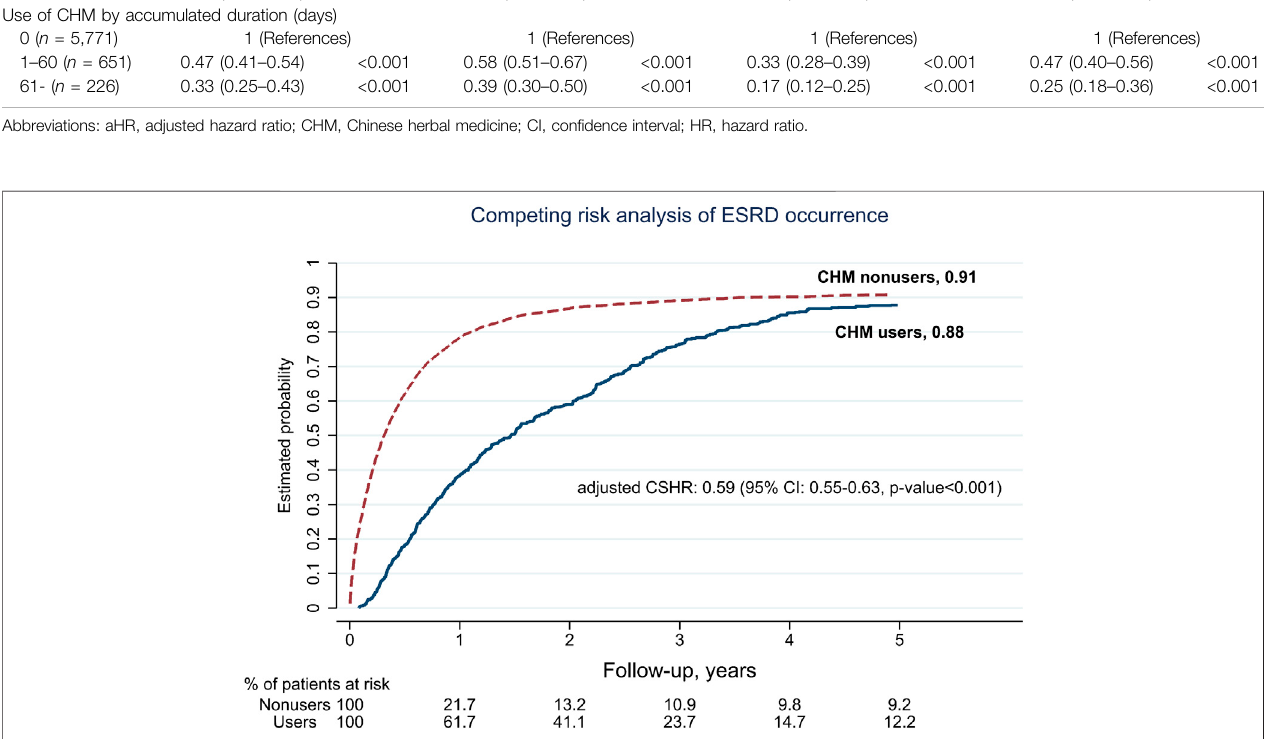
Different covariates matching/weighting methods 1:1 PSM ( n (cid:1) 1,744) Models with different populations with overlap weighting Model with 180-days landmark analysis ( n (cid:1)